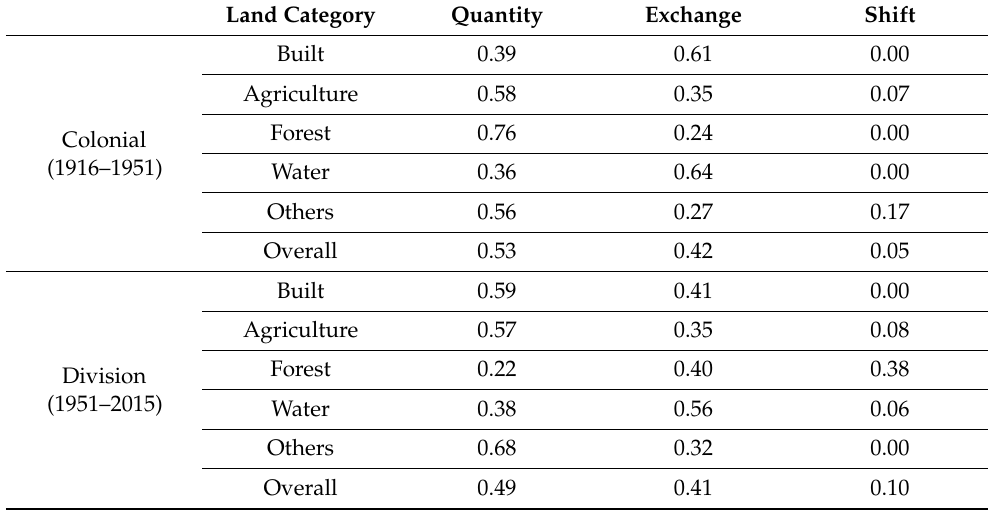
Table 3. Change component intensities and their Overall values. Land Category